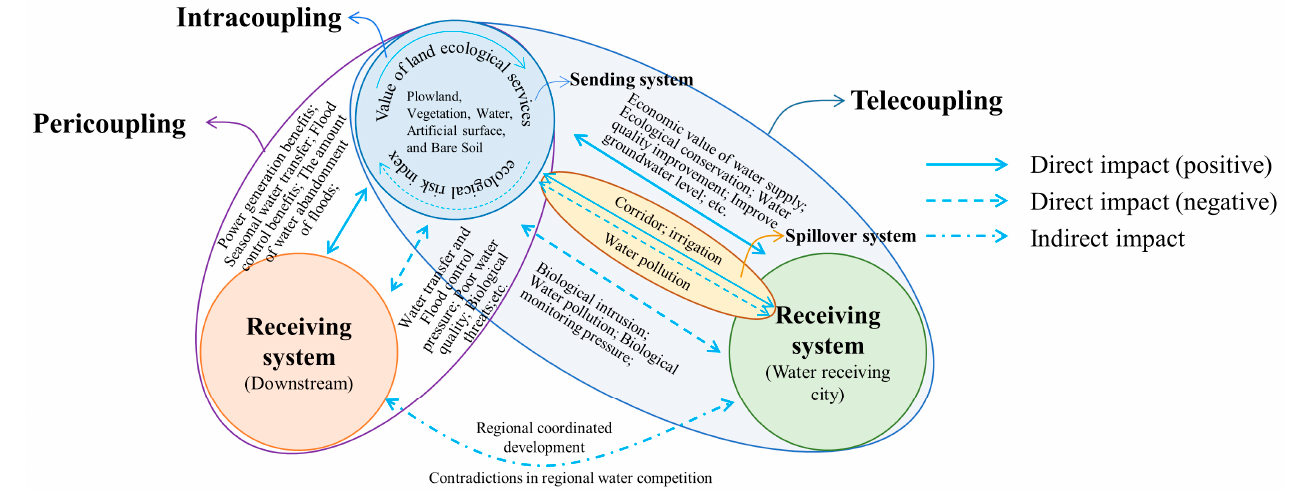
Figure 9. The ecological benefit feedback of the metacoupling of SNWTP ‐ MR.